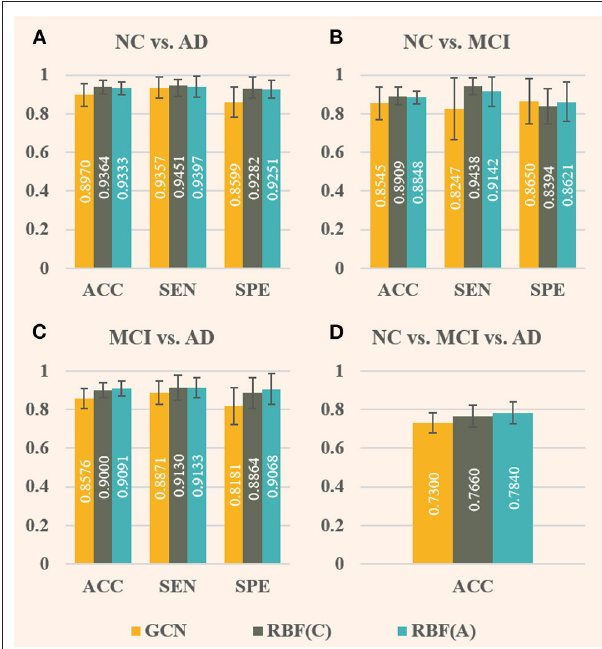
FIGURE 5 | Comparison of baseline GCN (denoted by GCN, in yellow) and both improved GCNs with RBF framework [denoted by RBF (C) , in green, and denoted by RBF (A) , in blue] for AD stages classification. Among them, RBF (C) corresponds to the RBF framework using the concatenation module, whereas RBF (A) corresponds to the one using the addition module. In this case, only baseline GCNs are embedded in the multichannel GCN module of the RBF framework. The specific index for each column is displayed in white in the middle. The error bars depict the standard deviation of the three evaluation indicators across the 10-folds, respectively. The panels (A–D) , respectively, display the results of the four groups of classification tasks.